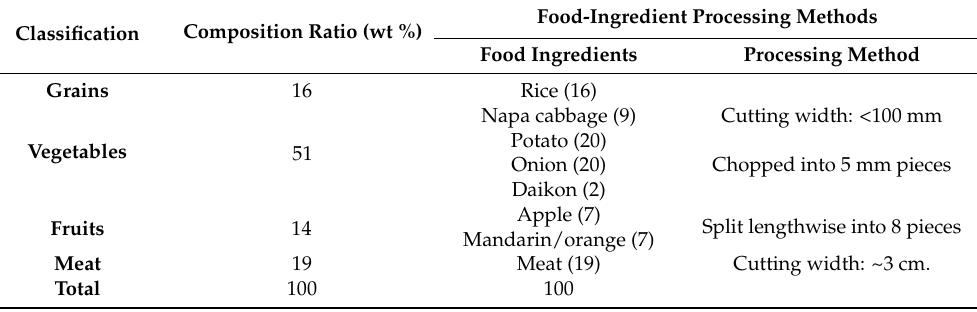
Table 1. Standard Food-Waste